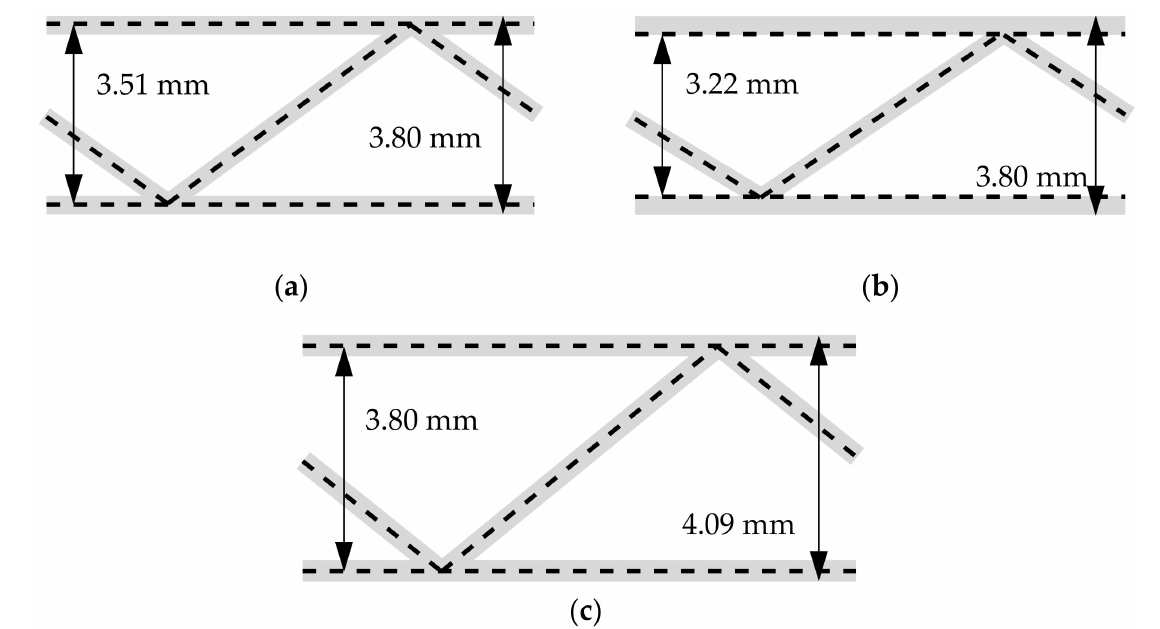
Figure 5. The different approach of modelling the cardboard cross-direction section of the saw tooth geometry: ( a ) 3.80 mm as the outer cardboard dimension, ( b ) 3.80 mm as the outer cardboard dimension with offset technique used and ( c ) 3.80 mm as axial spacing between liners.